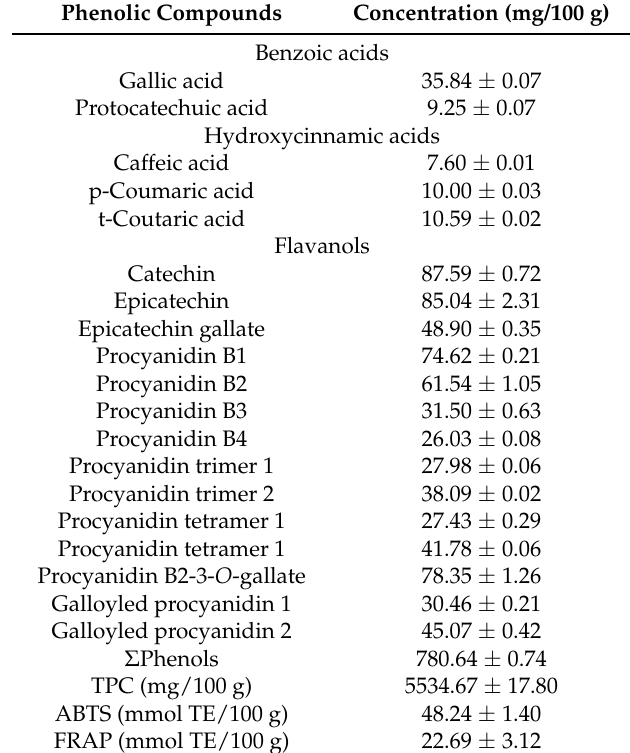
Table 1. Concentrations of phenolic compounds in seeds from grape pomace of the Pedro Ximénez